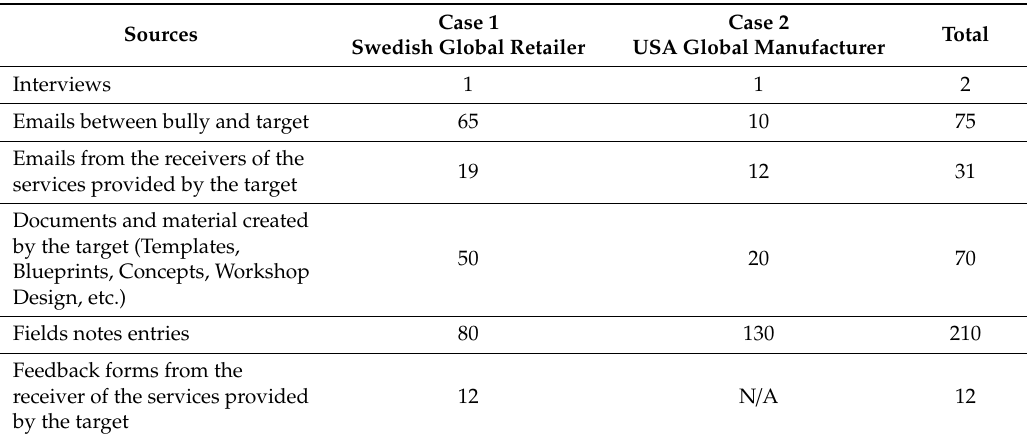
Table 2. Summary of the sources of